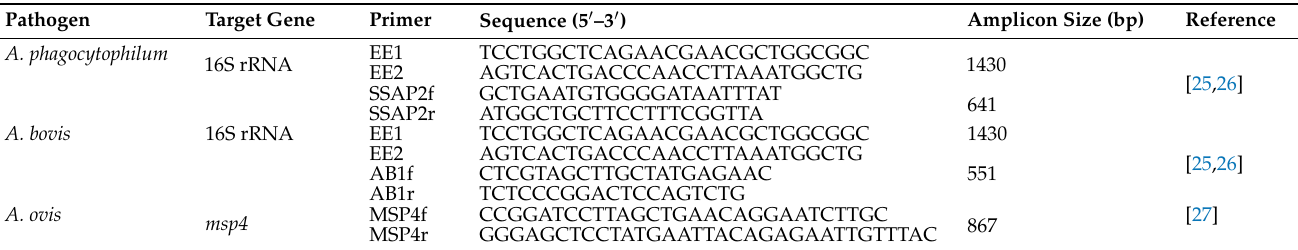
Table 2. Primers for PCR analysis in the present